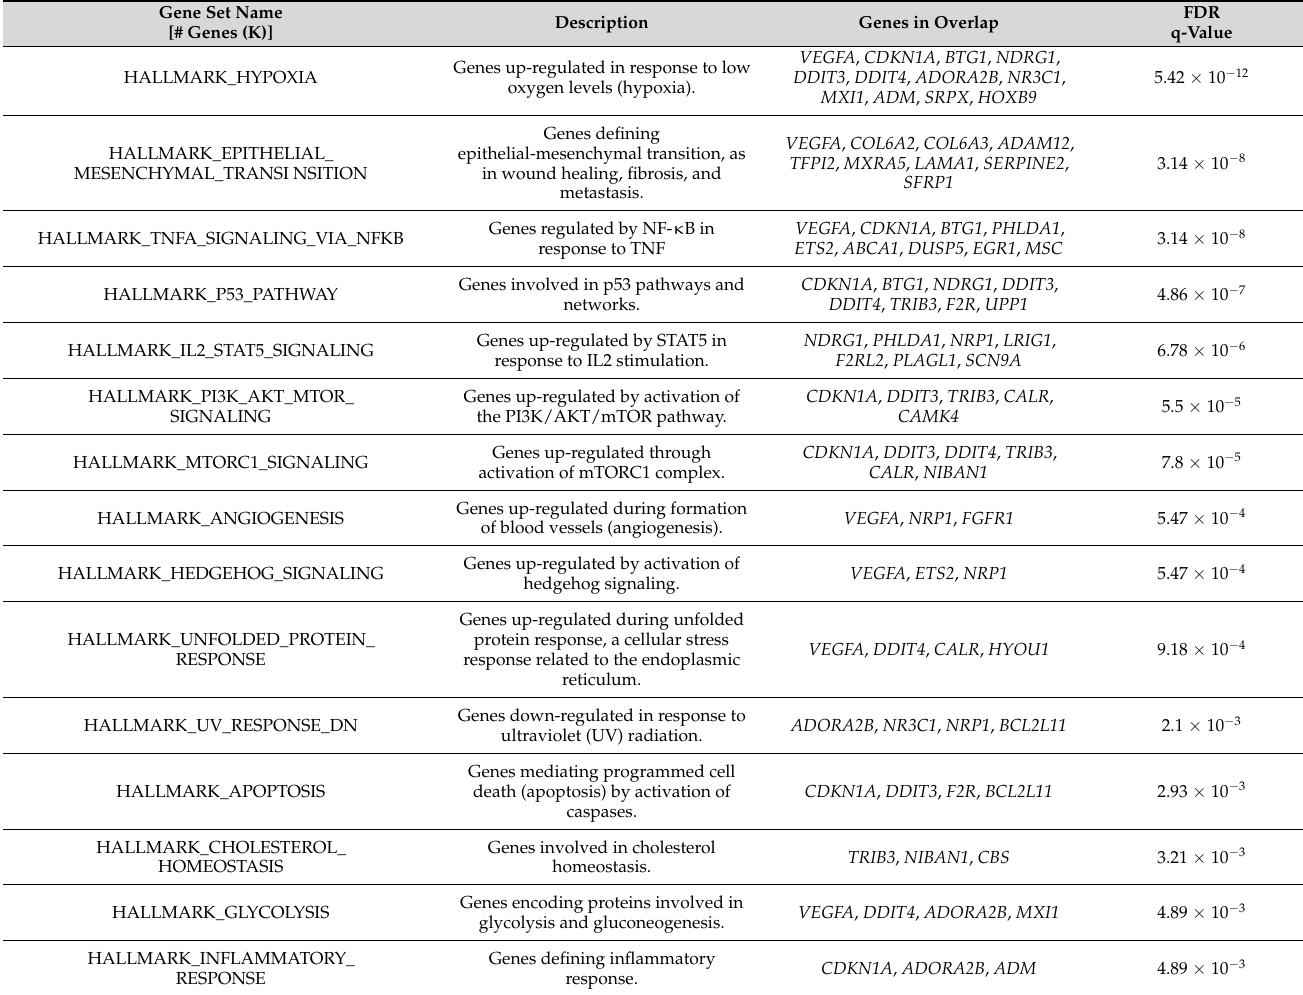
Table 3. GSEA based on the hallmark gene sets for upregulated genes of FE25L (p122) compared to FE25 (p19)